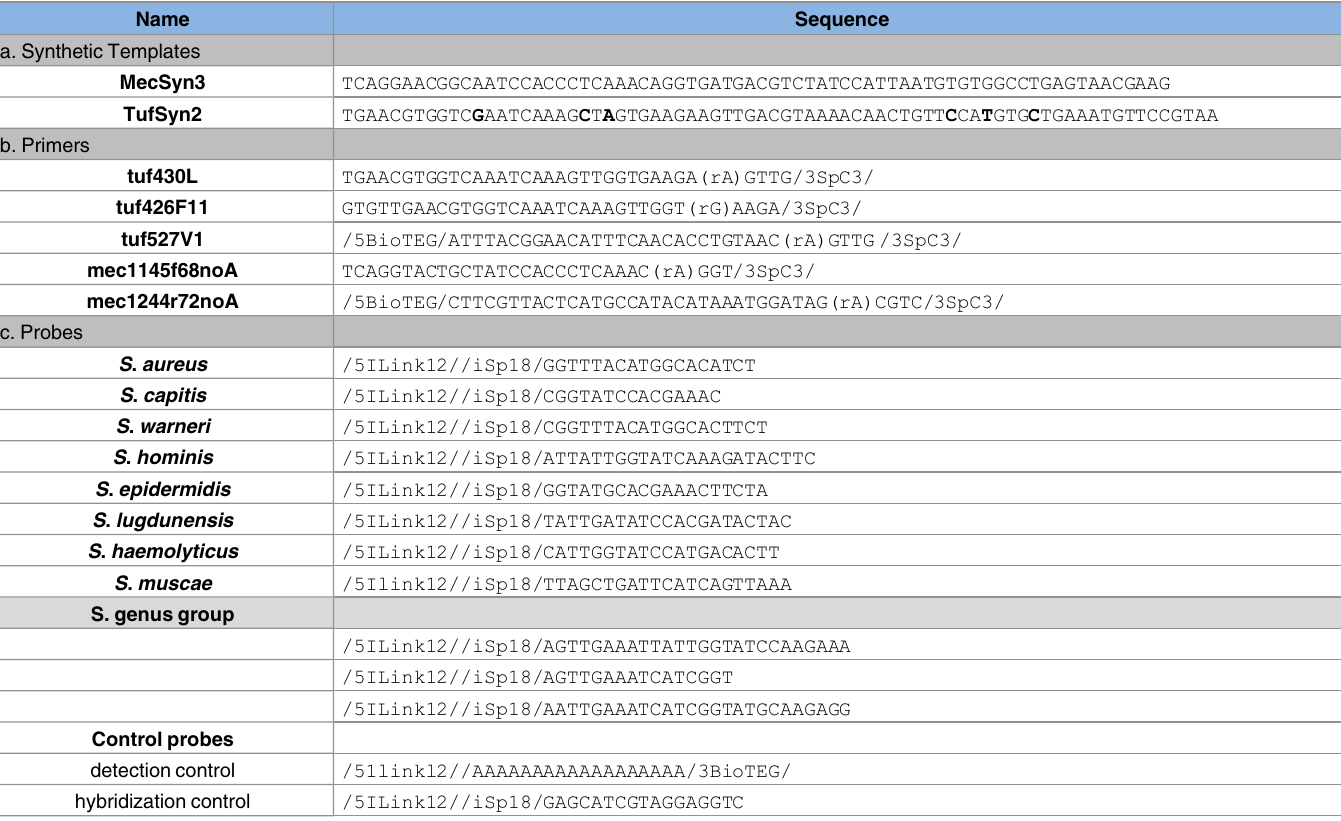
Table 1. List of synthetic template, primer and probe sequences used in this study.